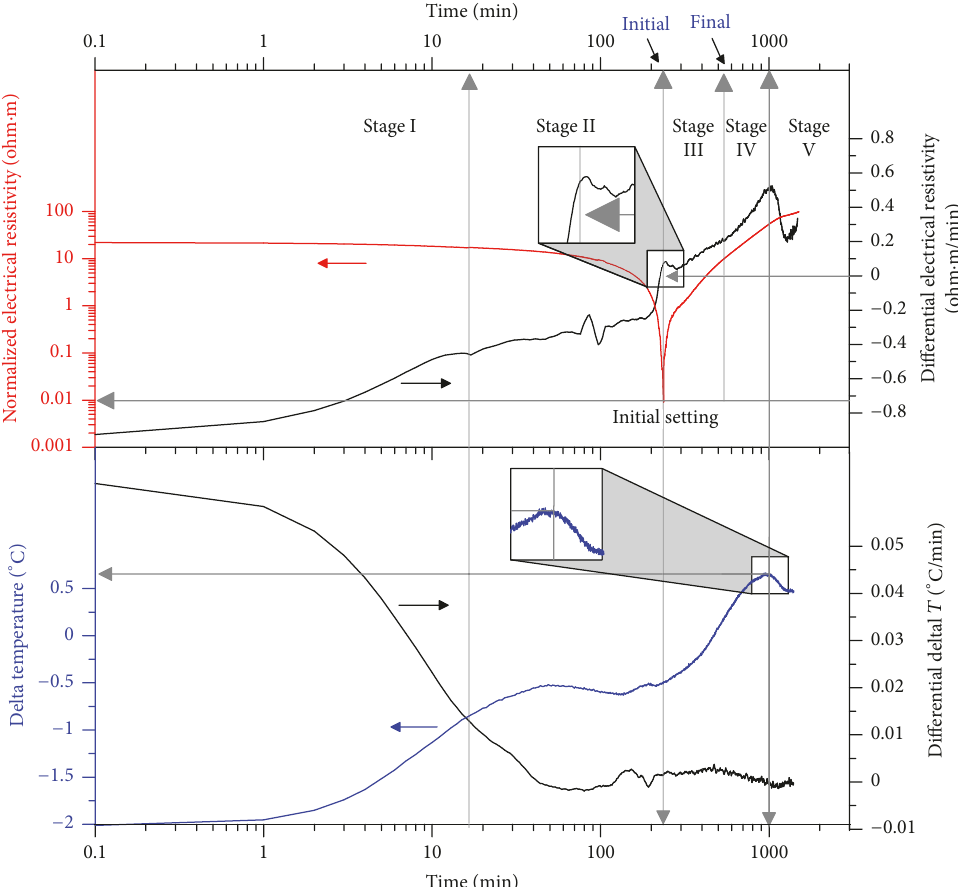
Figure 3: Electrical resistivity of Portland cement during hydration: five stages of Portland cement hydration according to [19].